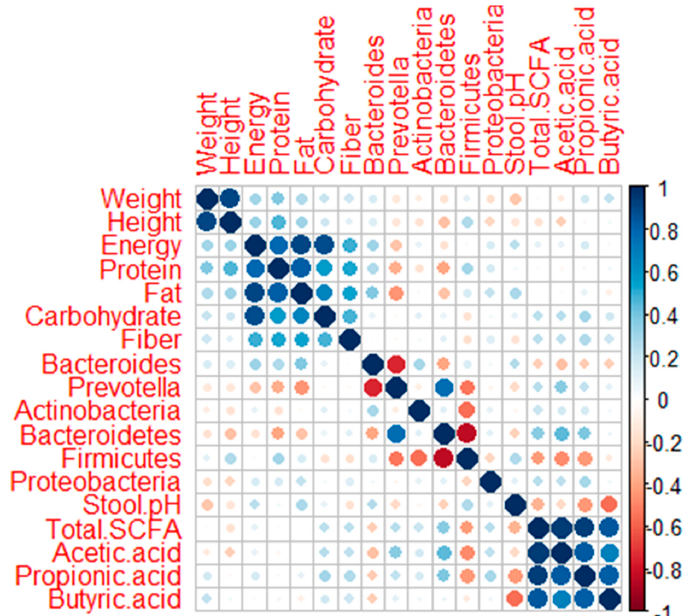
Figure 6. Corrplot showing the correlation between two parameters. The correlation was analyzed using the Spearman method. A bigger circle shows a higher correlation coefficient., A blue circle means positively correlated, while a red circle means negatively correlated.